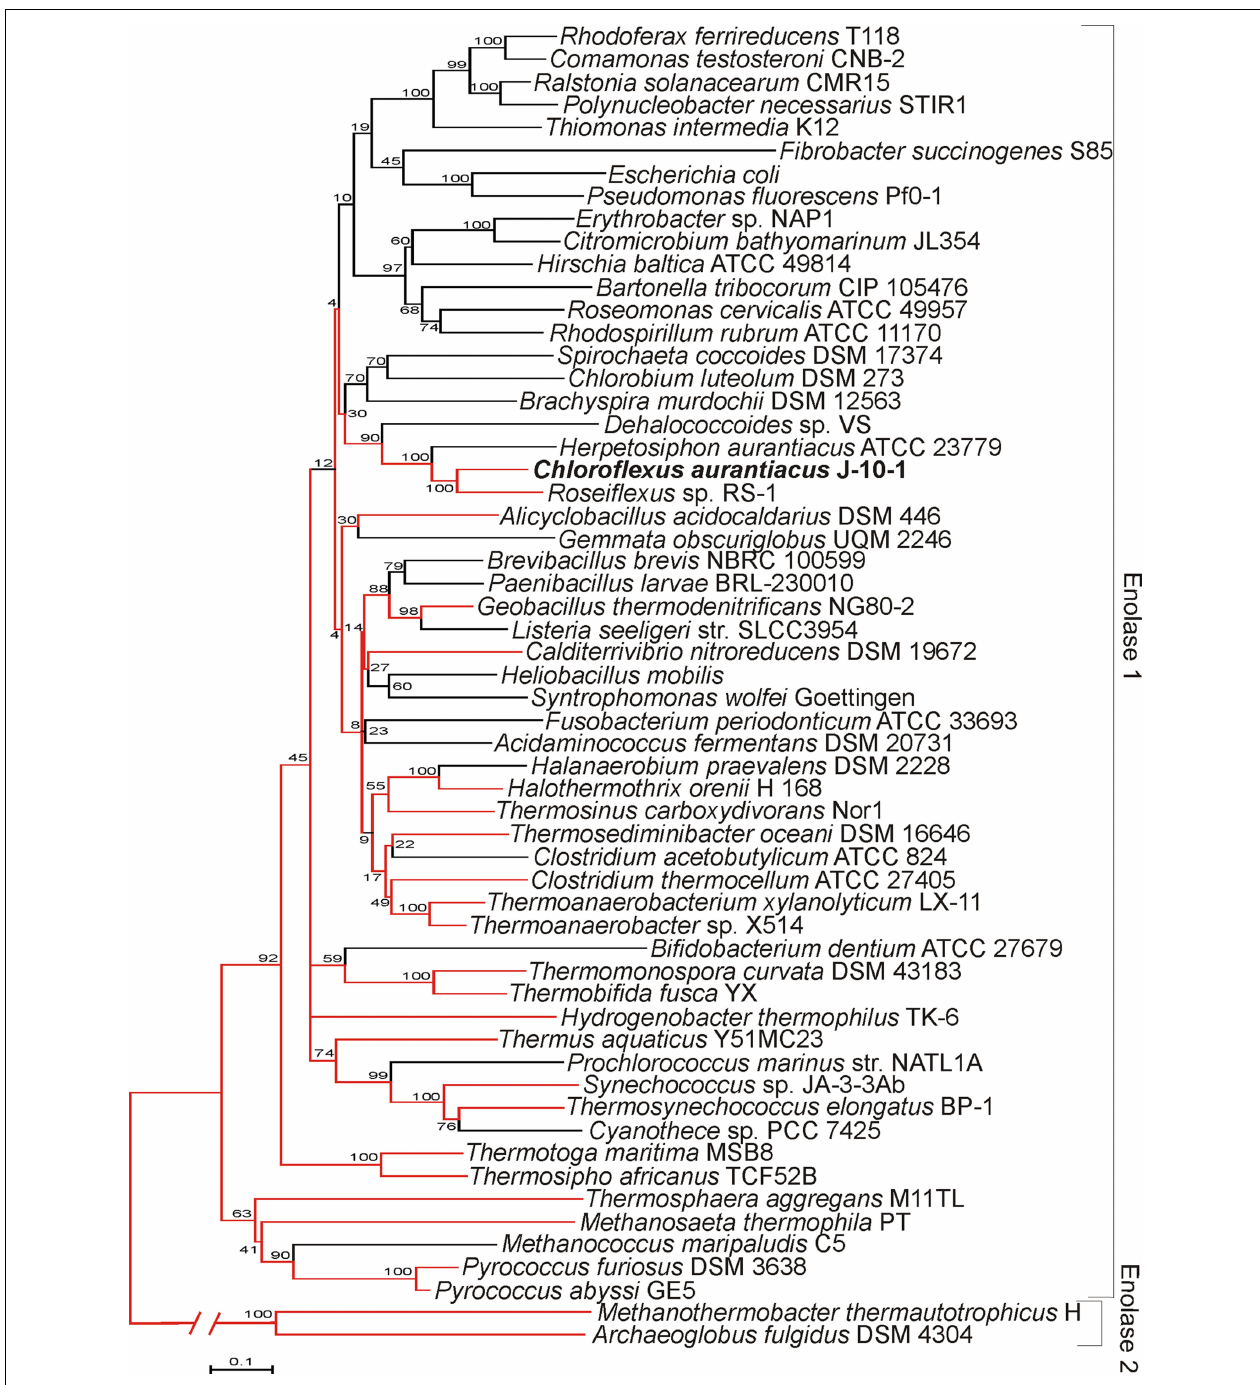
to designate thermophilic lineages in cases where both thermophilic and non-thermophilic taxa were present. Bootstrap support values are designated at